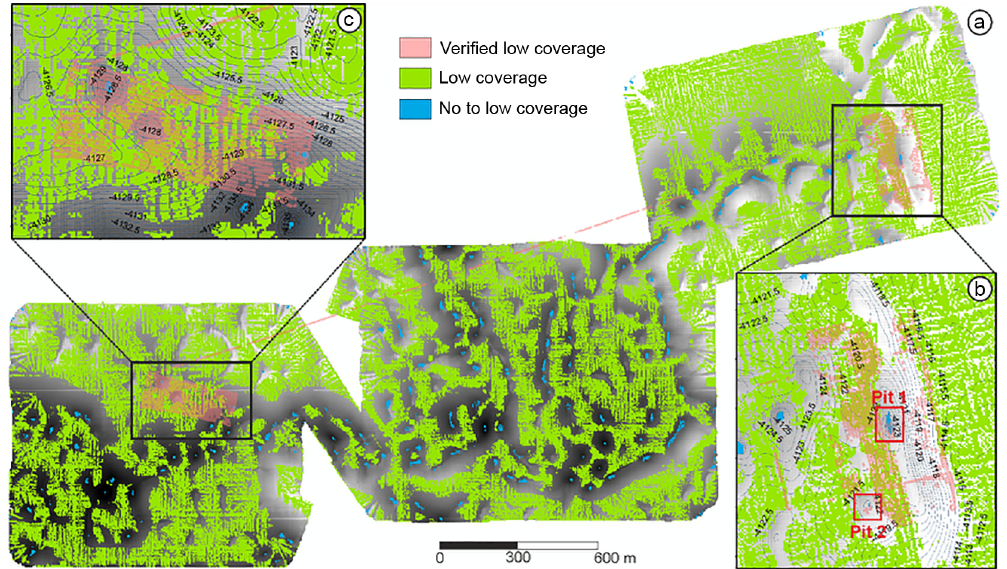
Figure 7. (a) Depth-shaded area, mapped hydroacoustically by the AUV; (b) A2 sub-area, (c) A1 sub-area. The green shading indicates low nodule coverage areas ( ≤ 12 . 5%) that have been classified based on the correspondence in sub-area A2 (low nodule coverage corresponds with slopes ≤ 1 . 8 ◦ and positive plan curvature). Red boxes in panel (b) mark distinct, almost nodule-free, morphological depressions (Pits 1 and 2). Blue shades indicate areas with a high probability of very low to no Mn-nodule coverage. See classification dictionary in Table A5.